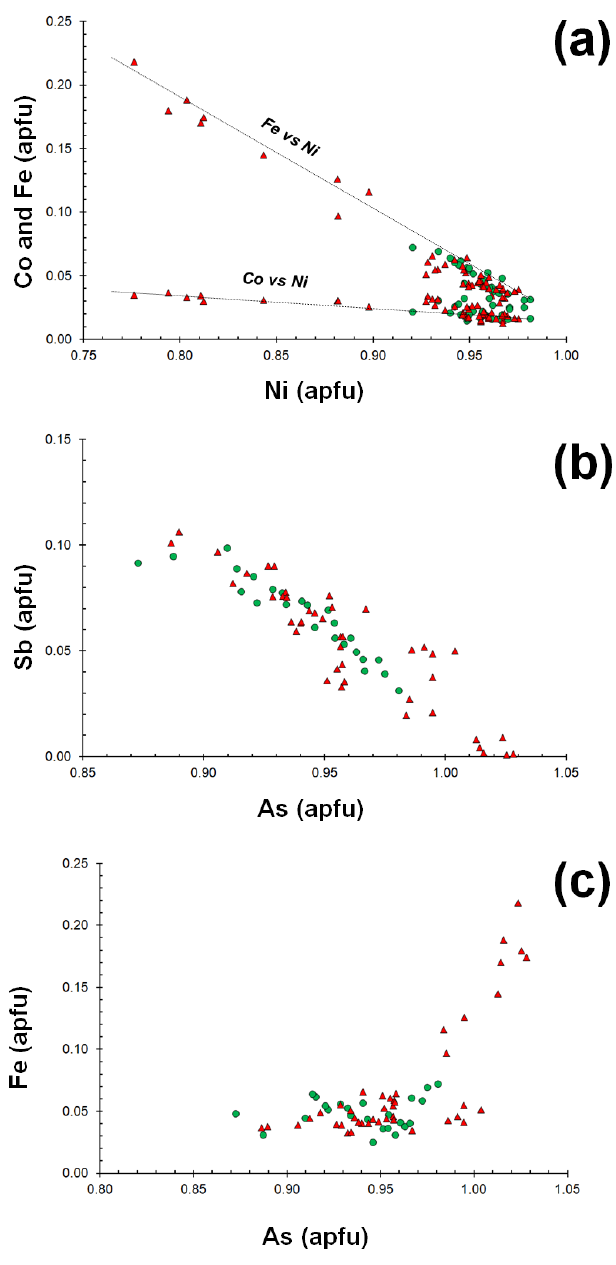
Figure 5. Relations between chemical constituents in gersdorffite from the Contrada Zillì. Same symbols as in Fig.